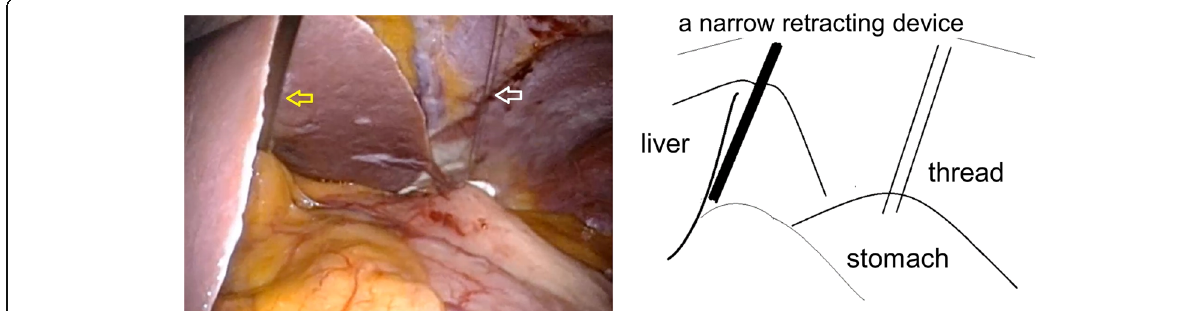
Fig. 1 The way of our keeping the operative field. A suture was placed across the gastric wall at the anal side of the tumor, and the thread was pulled out from the abdominal cavity (white arrow). The left lateral segment of the liver was elevated with a narrow retracting device (yellow